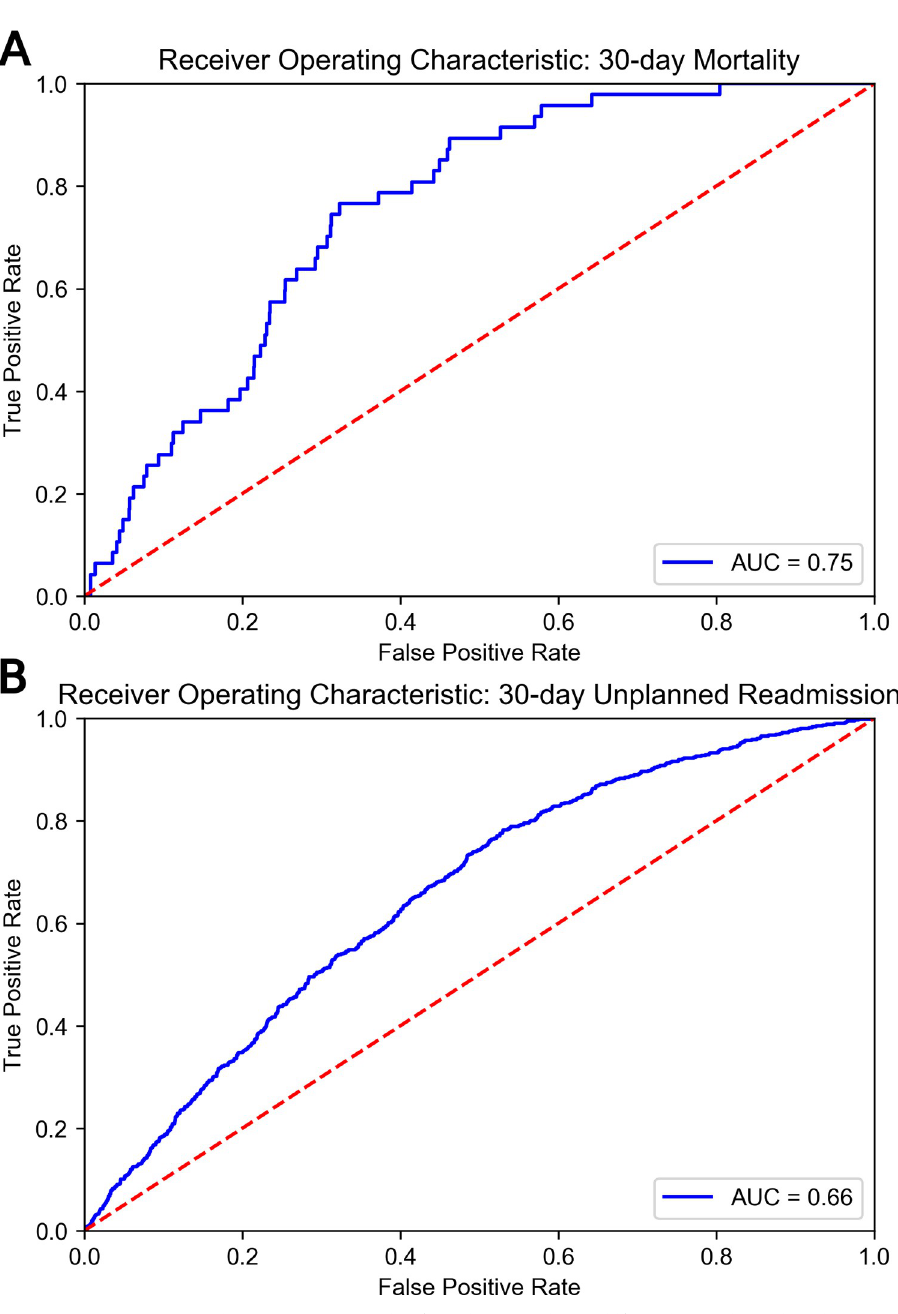
Fig 2. Receiver-operating characteristic curves for a) 30-day mortality and b) 30-day unplanned readmission models. mortality: DeLong p-value = 0.322, 30-day readmission: DeLong p-value = 0.939), male and female patients (30-day mortality: DeLong p-value = 0.804, 30-day readmission: DeLong p- value = 0.130), and age � 65 and < 65 years (30-day mortality: DeLong p-value = 0.804, 30-day readmission: DeLong p-value = 0.130). AU-ROC curve comparisons for each subgroup are pictured in Fig 5.